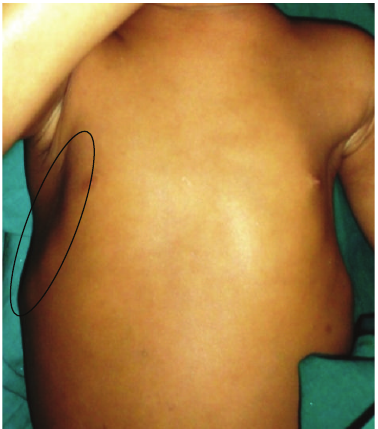
Figure 11: Showing Harrison’s groove on the chest